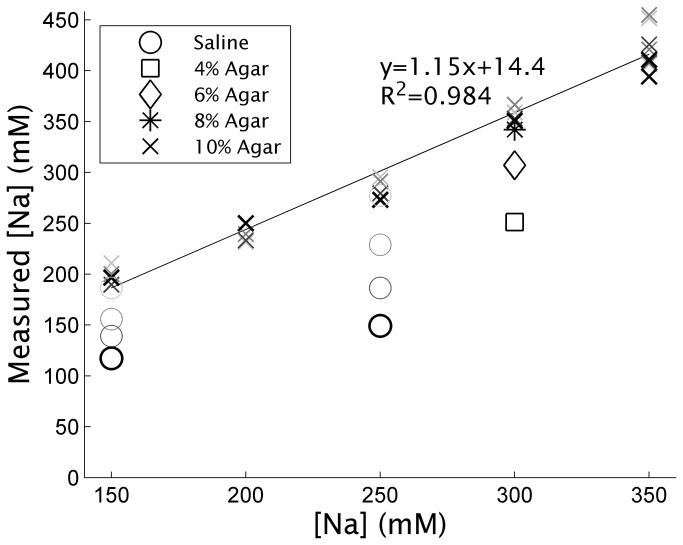
Sodium concentrations measured with 3D UTE imaging of sodium phantoms across varying TRs.The lightest plot symbols correspond to a 100ms TR, darkening with as drops to 50ms, 30ms, and finally 15ms for the darkest plot symbols. All data has been corrected for the incomplete T1 relaxation of cartilage sodium using the 250mM cartilage-mimicking 10% agar phantom. A strong linear relationship between image intensity and mean sodium concentration is found in the 10% agar cartilage like phantoms. Saline ROIs show an underestimation of the sodium concentration, which reduces as TR increases. Lower concentrations of agar underestimate the sodium concentrations more like saline, as could be expected.